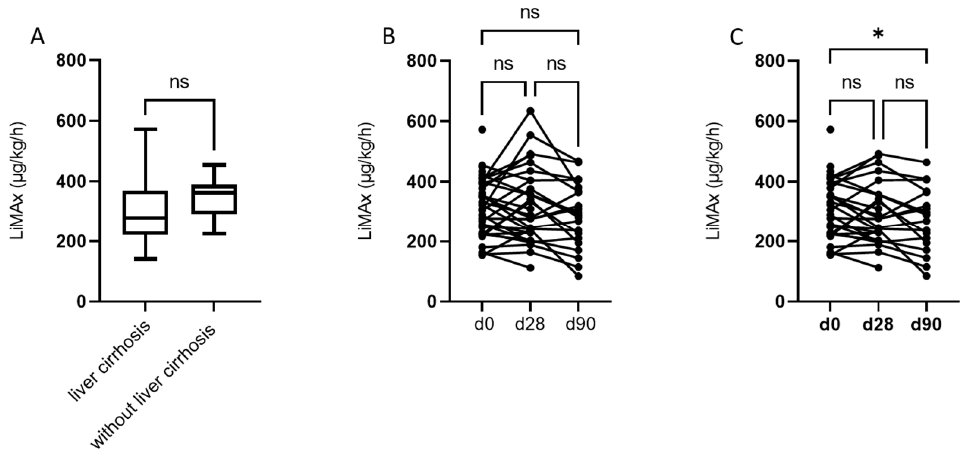
Figure 1. ( A ) Baseline LiMAx ® is not different in patients with or without liver cirrhosis (with liver cirrhosis median 279 µ g/kg/h, IQR: 220–370.5 µ g/kg/h; without liver cirrhosis median 363 µ g/kg/h, IQR 291–389.5 µ g/kg/h; p = 0.1464); ( B ) LiMAx ® at d0, d28, and d90 for the entire prospective cohort;